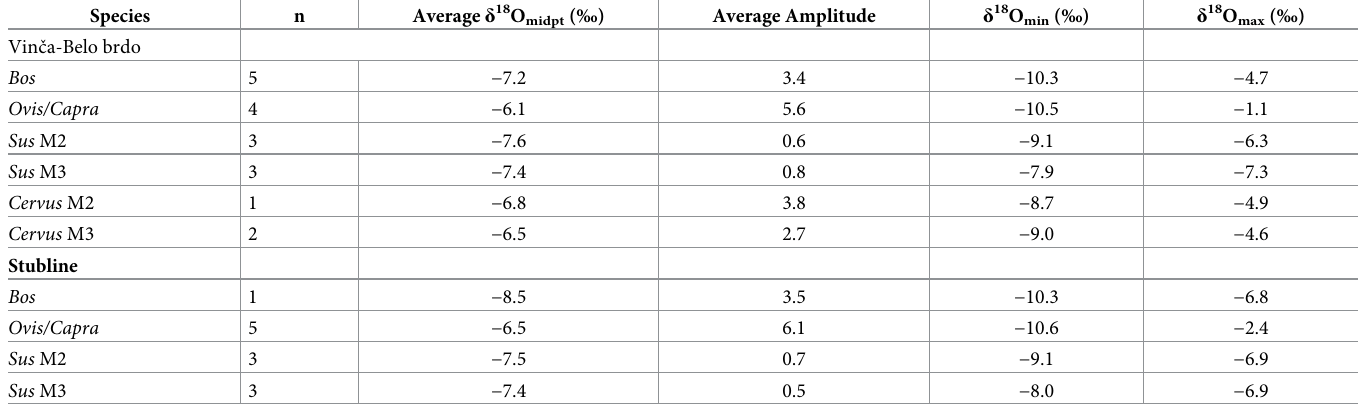
Table 1. Summary of δ 18 O values from the incremental analysis of cattle ( Bos taurus ), sheep/goat ( Ovis aries/Capra hircus ), pig ( Sus scrofa ), and red deer ( Cervus elaphus ). Results for individual teeth are in S2 Table.